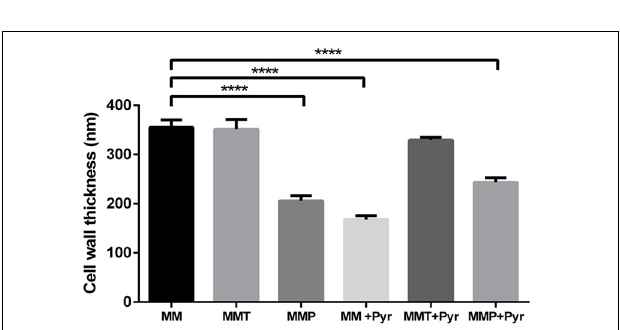
FIGURE 5 | Measurement of the A. alternata cell wall when grown in MM, MMT, MMP and under these conditions with pyroquilon. A. alternata was cultivated in liquid cultures for 3 days with alternating 16-h light and 8-h dark periods. Results are the mean ± the standard error of the mean of triplicates of three independent experiments (Student’s t -test). **** P <